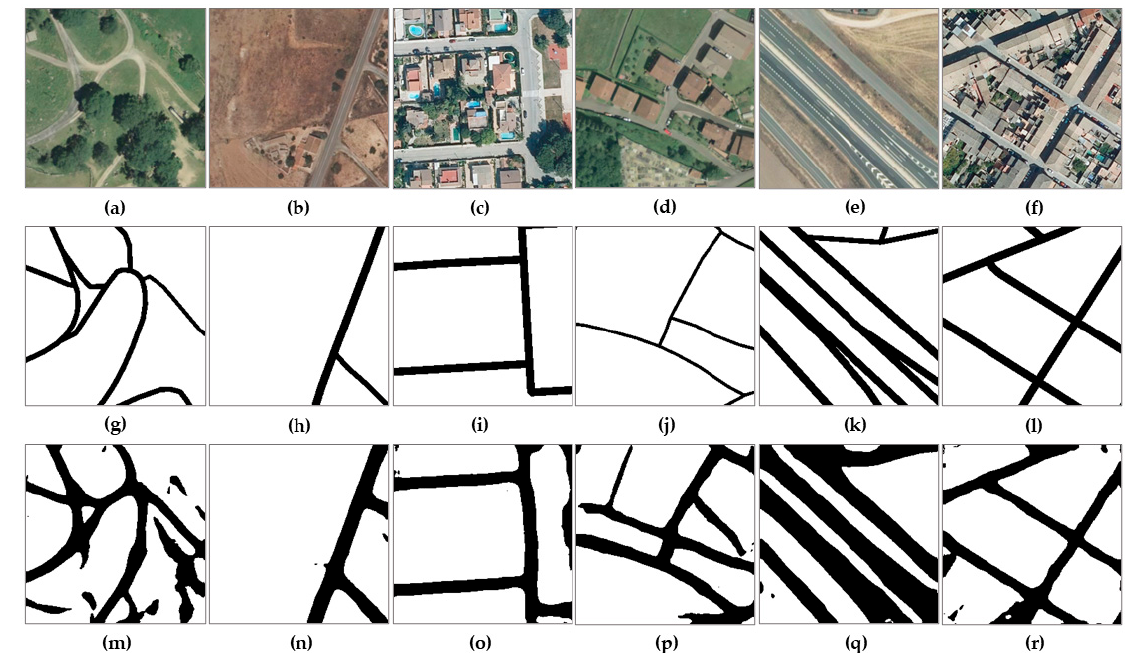
Figure 2. The relation between the aerial orthoimage (first row ( a – f )), the rasterized segmentation mask (ground-truth or real sample coming from MTN25, found in the second row ( g – l )), and the semantic segmentation predictions (conditional information, x , seen in third row ( m – r )). Note: The train set used as conditional information for G contains the same 6784 tiles as the set from the target distribution y . The same is valid for the test set (unseen